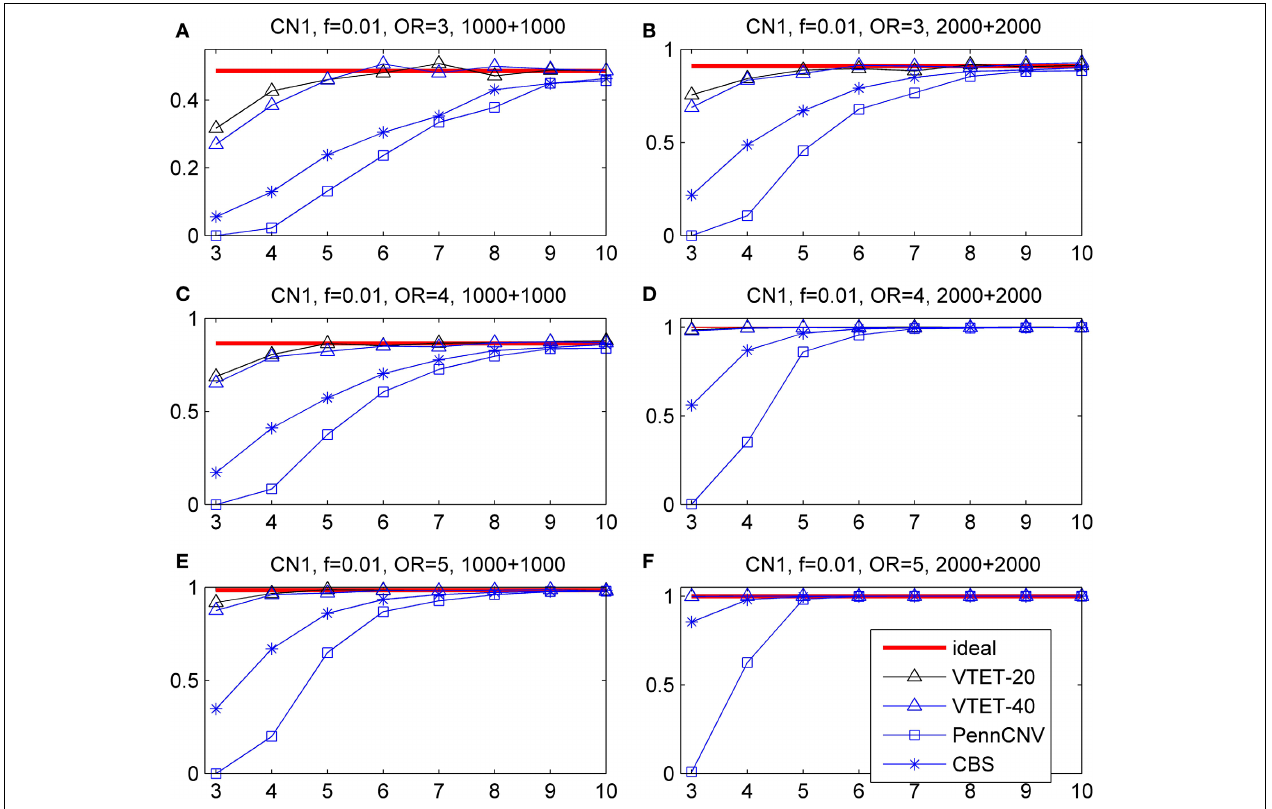
α = 0 . 001. “ideal” denotes the power when CNV status is known and thus represents the limit of the performance of any method. “PennCNV” and “CBS” are the powers from the two-step approach: first calling CNVs using the algorithms and then testing associations based on identified CNVs. The power of PennCNV or CBS does not depend on the length of the interval. “VTET-20 (40)” is the power for detecting CN1 associations in a genomic region with 20 (40) probes using